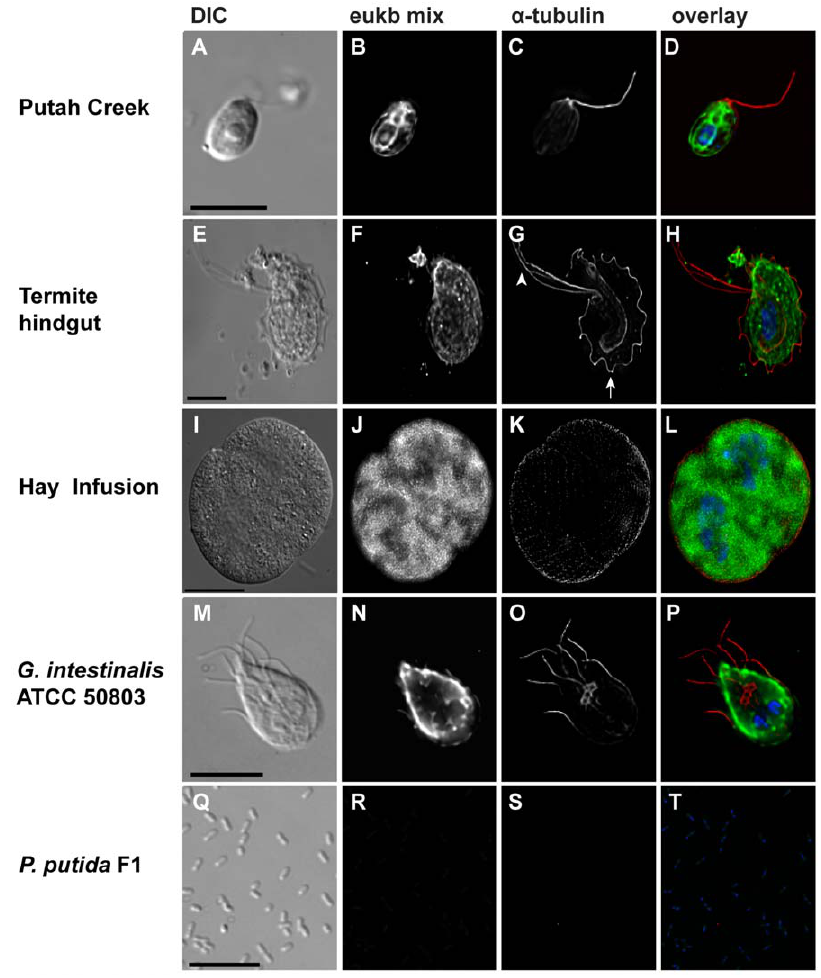
Figure 1. ImmunoFISH links phylotype with cytoskeletal morphology in protists from three environments. Representative immunoFISH of protists in Putah Creek (A–D), the termite hindgut (E–H), and the hay infusion enrichment (I–L) are presented. Positive control of the protist G. intestinalis ATCC 50803 (M–P) and negative control of the bacterium P. putida F1 (Q–T) are also shown. Fixed samples were hybridized with the broad eukaryote ssu rRNA probe (B, F, J, N, R) and overlaid with an anti- a -tubulin antibody to stain cytoskeletal features of each cell (C, G, K, O, S). The image overlays (also 3D stack in Video S1) show the eukaryote ssu rRNA probe (green), anti- a -tubulin antibody (red), and DAPI nucleic acid stain (blue) (D, H, L, P, T). Scale bars=10 m m with the exception of the hay infusion enrichment (I) with the scale bar=25 m m.